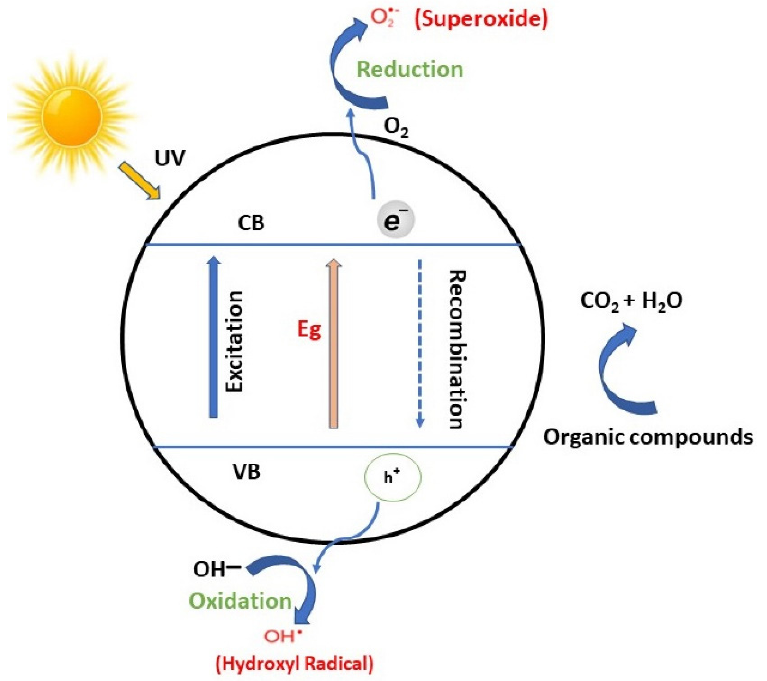
Figure 3. Basic scheme of semiconductor − mediated photocatalytic process [38] .